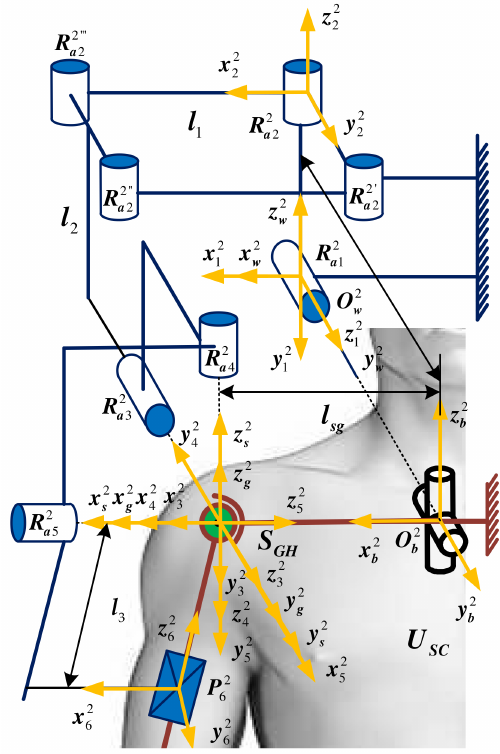
Figure 9. 5 R a 1 P mechanism and upper limb closed